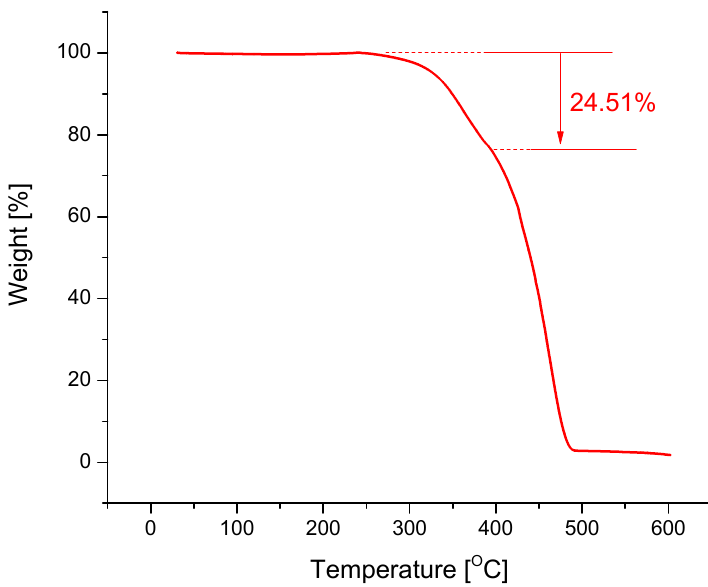
Figure 4. Thermogravimetric analysis curves of Wax3D filament. Table 8. Values obtained from TGA.